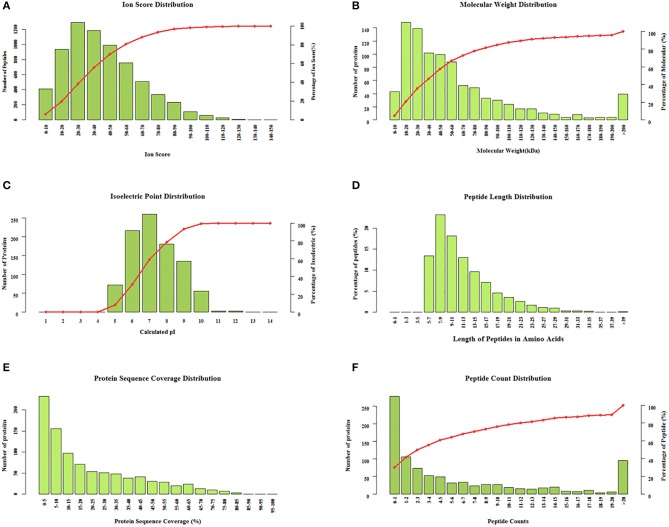
Identification and evaluation of the quantitative results from the tandem mass tag-based proteomics analysis. Protein distributions according to (A) ion score, (B) molecular weight, (C) isoelectric point, (D) peptide length, (E) protein sequence coverage, and (F) peptide count.